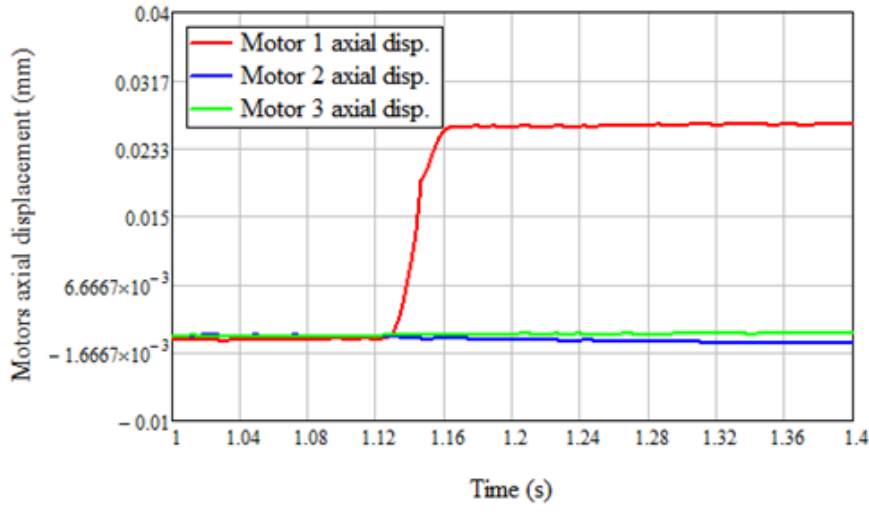
Figure 21. Time variations of axial deformations for the mass of 1.5 kg. The average values of the displacements after the application of the weight were calculated in the time interval (1.3, 1.4) s.